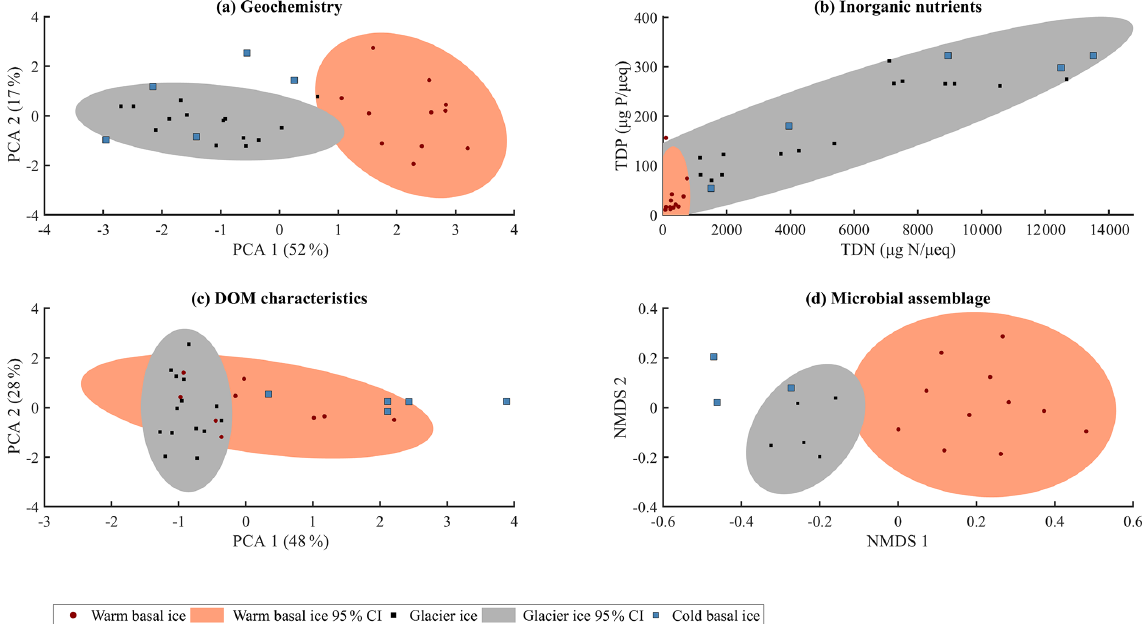
Figure 2. Summary of (a) major ion composition produced by PCA using the contribution of each major ion to the solute load, with each major ion normalized to its mean and variance. (b) Inorganic nutrients relative to the solute load (TDP, µgPµeq − 1 ; TDN, µgNµeq − 1 ). (c) Character of dissolved organic matter determined by principle component analysis using the relative contributions of the five modelled fluorescent components, with each component normalized to its mean and variance. (d) Microbial assemblage structure determined by non- metric multidimensional scaling (NMDS) of Bray–Curtis distance measure using 16S rRNA gene sequencing (stress =